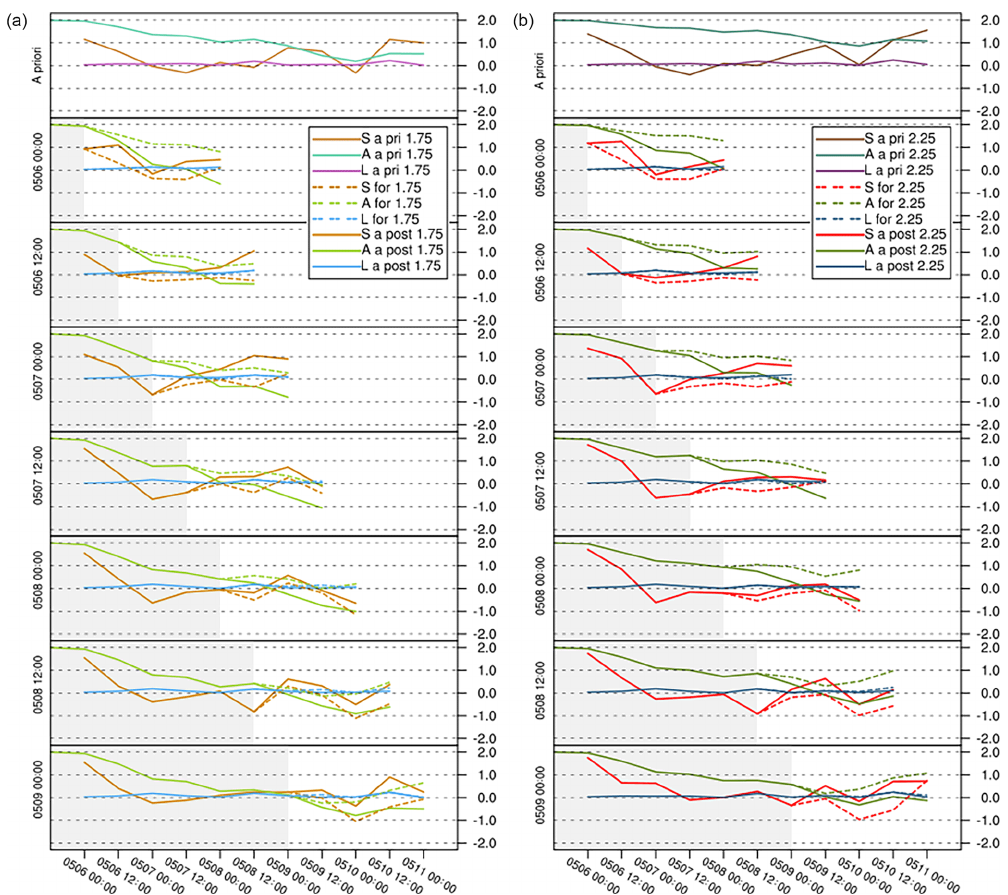
Figure 11. SAL (structure, amplitude, and location) results for model simulations run with the a priori emissions calculated for the 1.75 (a) and 2.25 (b) satellite retrieval (top row), and results for the model simulations using a posteriori emissions started every 12h from 6 May at 00:00UTC to 9 May at 00:00UTC with a 48h forecast using either a forecast emission estimate (dashed lines) or a zero ash emission term in the forecast (straight lines). Grey areas show the assimilation period where the emission estimate is calculated by the inversion. Model simulations with the 1.75 a posteriori source term are compared to the 1.75 satellite observation field, and those with the 2.25 a posteriori emissions are compared to 2.25 satellite retrievals. Date format: MMDD; e.g. “0506” stands for 6